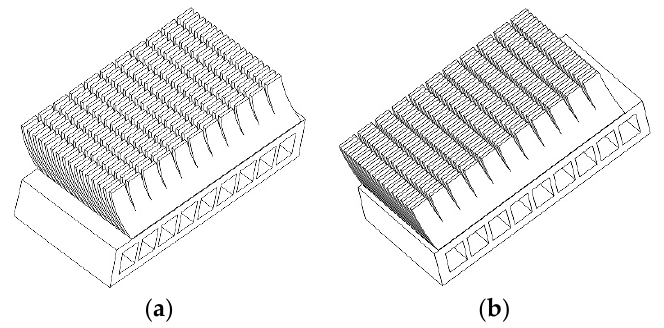
Figure 4. Two kinds of heat transfer units (HTUs): ( a ) HTU A; ( b ) HTU B.